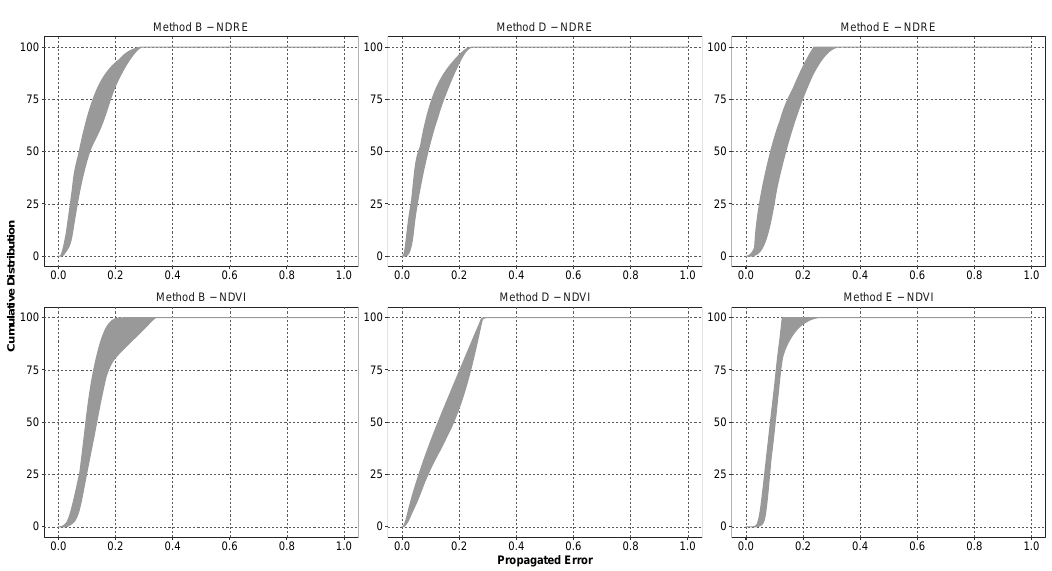
Figure 10. Cumulative distribution of the propagated error within the normalized difference vegetation index (NDVI) and normalized difference red-edge index (NDRE) data for radiometric calibration methods B, D, and E. The grey areas represent the variability observed between flights for index and calibration